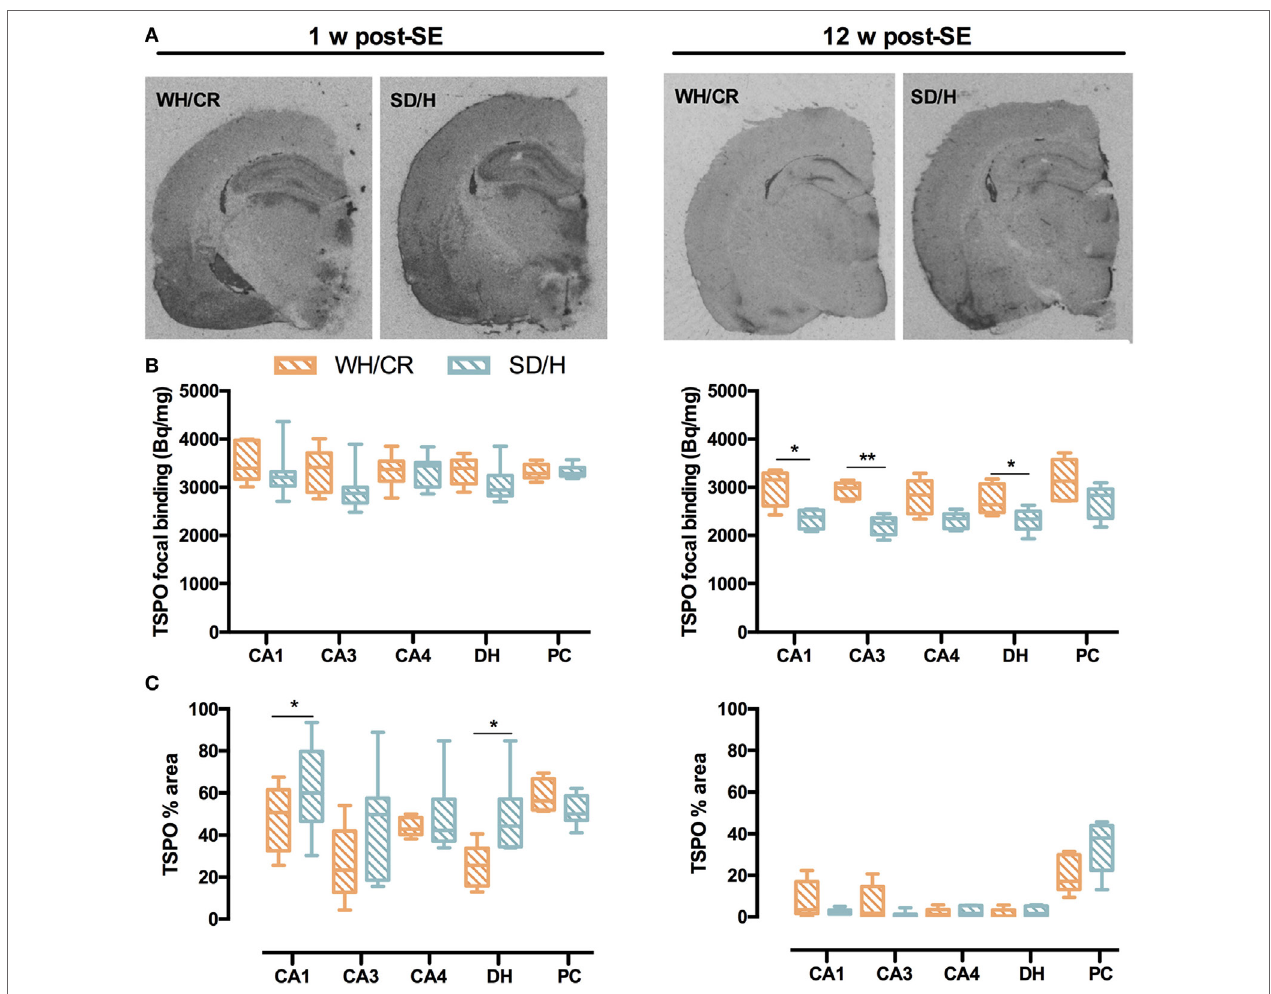
FigUre 6 | TSPO focal binding and % area in WH/CR and SD/H rats. (a) Representative autoradiograms showing TSPO expression 1 and 12 weeks post-status epilepticus (SE). (B) TSPO focal binding in the subacute phase was similar for the two strains, while in the chronic phase, it was higher for the KASE WH/CR rats for all the brain regions except for the CA4 and PC when compared to KASE SD/H animals. (c) The TSPO% area was significantly increased in the KASE SD/H animals in the CA1 and DH when compared to the KASE WH/CR rats 1 week post-SE. Twelve weeks post-SE no differences could be determined. Mann–Whitney U test (B,c) . * p < 0.05, ** p < 0.01. KASE WH/CR n = 5–7 and KASE SD/H n = 6. TSPO, translocator protein; WH/CR, Wistar Han/Charles River; SD/H, Sprague-Dawley/ Harlan; w, week; CA, cornu ammonis; DH, dentate hilus; PC, piriform cortex; KASE, kainic acid-induced status epilepticus